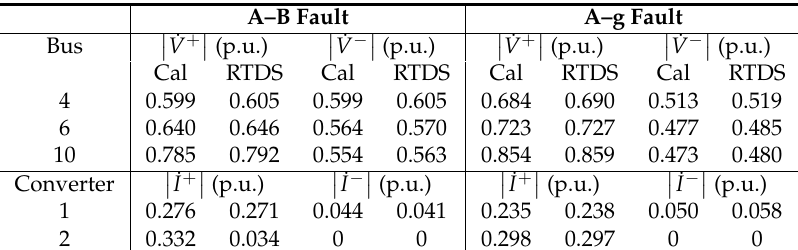
Table 3. Comparison between calculations and simulations (S2).